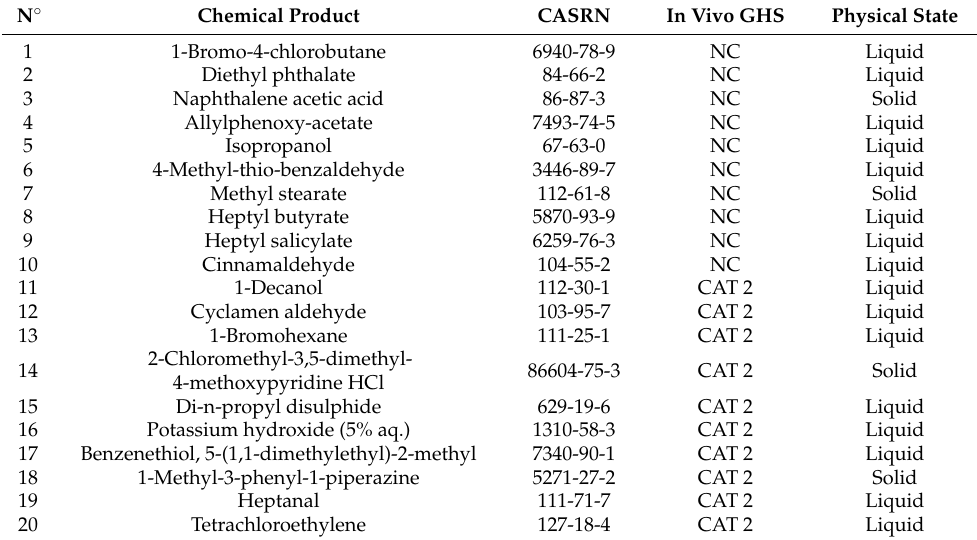
Table 1. List of test chemicals used in this study.